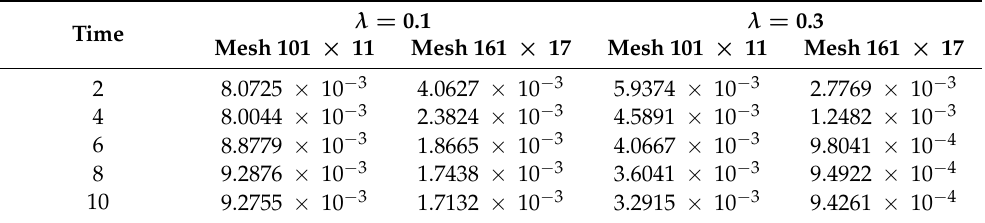
Table 9. Example No. 3—comparison of RMSE for Pe = 1000, λ = 0.1, λ = 0.3, and different meshes.